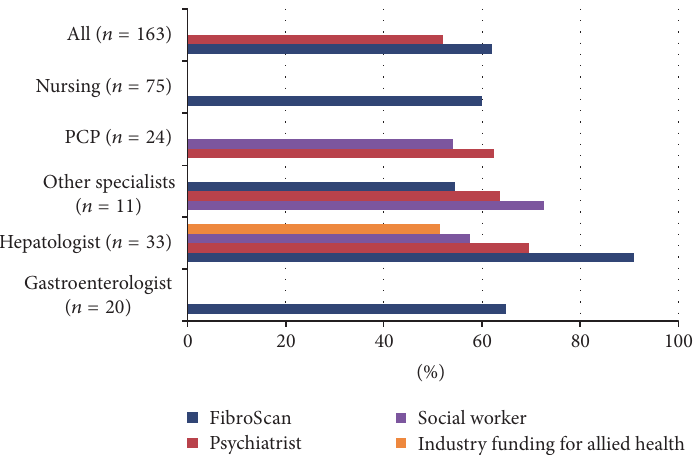
Figure 1: Access to HCV practice needs by specialization.